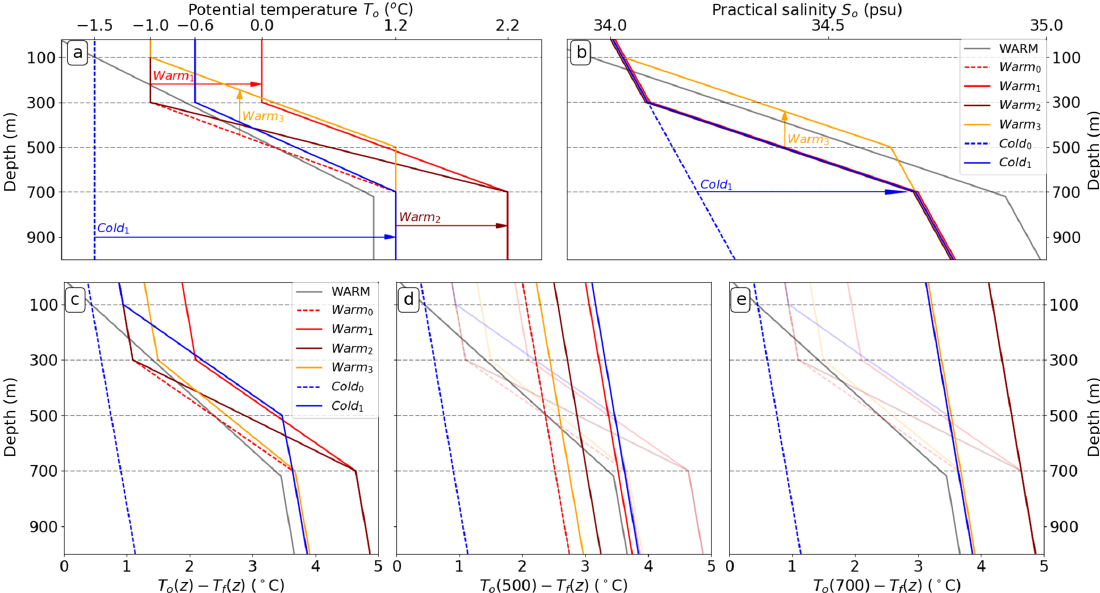
Figure 3. Far-field ocean temperature (a) and salinity (b) profiles scenarios in front of the cavity. The WARM profile is used for calibrating the initial state of parameterised and coupled simulations. The Warm 0 and Cold 0 scenarios are constant in time, while the others evolve linearly in time following the arrows. The Warm 1 , Warm 2 , and Warm 3 scenarios start with the Warm 0 profile and end up after a century in their respective profiles, while the Cold 1 scenario starts from the Cold 0 profile. In (b) , profiles Warm 0 , Warm 1 , and Warm 2 are equal. Thermal forcing is calculated from the far-field temperature and salinity and applied to the ice-shelf draft, (c) assuming horizontal circulation between the far-field ocean and the cavity or assuming that the circulation is driven by oceanic properties at (d) 500m and (e) 700m depths. Profiles from the (c) panel are superimposed to panels (d) and (e) as a watermark for comparison purposes. The Warm 1 and Warm 2 profiles are equal in panel (e)